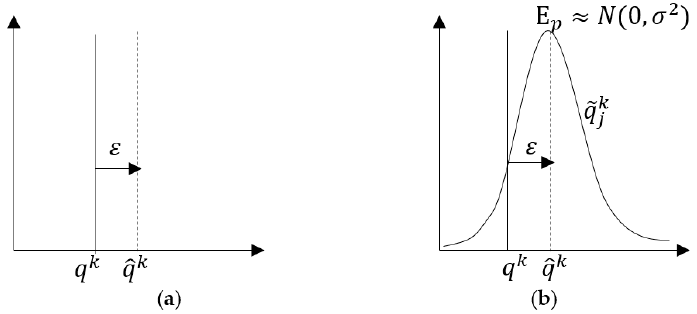
Figure 2. Schematic of single time-step streamflow forecast uncertainty: ( a ) DSF schematization; ( b ) PSF schematization. q k stands for observed inflow. ε stands for relative inflow forecasting error. ˆ q k stands for DSF member. (cid:101) q k stands for j th PSF member. k stands for time index. DSF is represented by random perturbation using relative inflow forecasting error ( ε